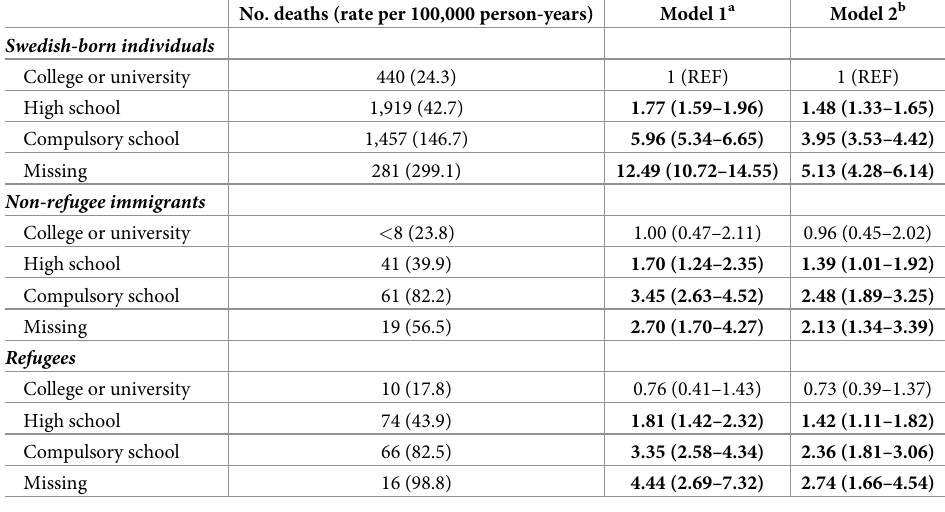
Table 3. Associations between educational level and all-cause mortality 2005–2016 in Swedish-born individuals and refugee and non-refugee immigrants, aged 19–25 years old residing in Sweden in 2004. Hazard ratios (HRs) with 95% confidence intervals